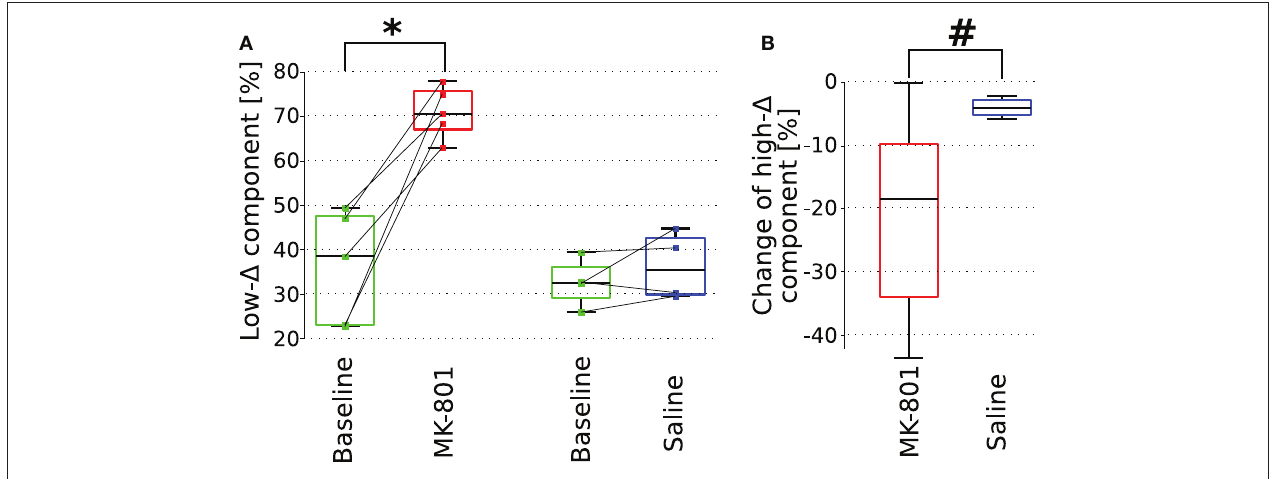
Figure 8 | Comparison of LFP oscillation properties following intra-thalamic (MD) microinjection of saline or MK-801. (A) A significant increase in low‑delta power after local injection of MK‑801 ( p = 0.004) but not saline into the MD. As noted at Figures 7D and 9D both MK‑801 and